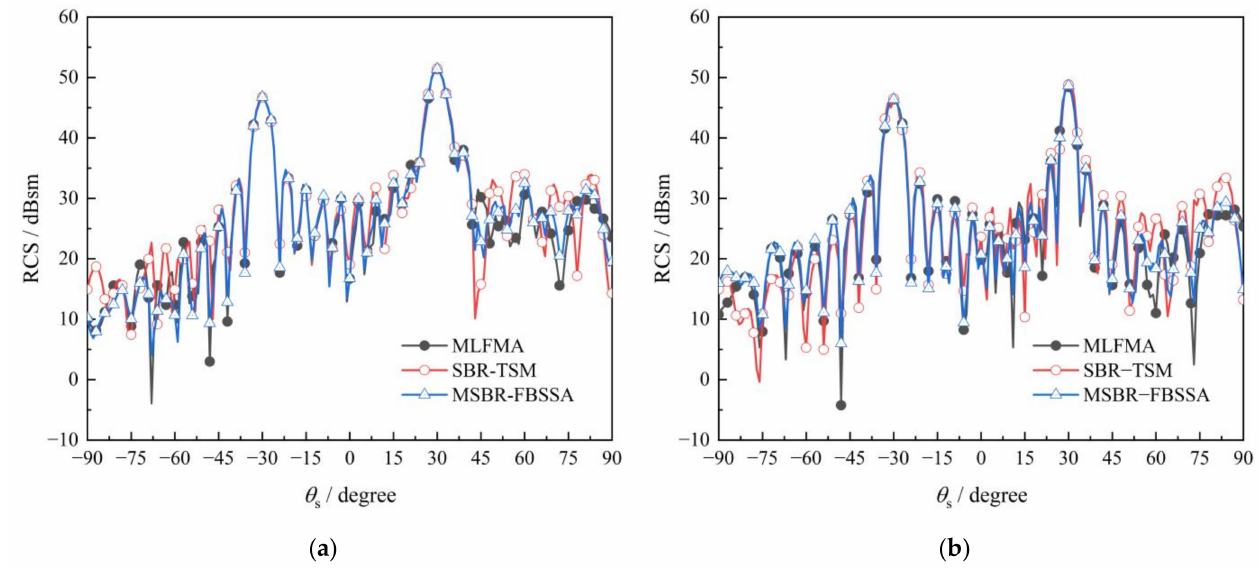
Figure 9. Bistatic RCS of a flare above cosine-canyon composite rough surface: ( a ) HH polarization; ( b ) VV polarization. Table 1. Efficiency and accuracy of different